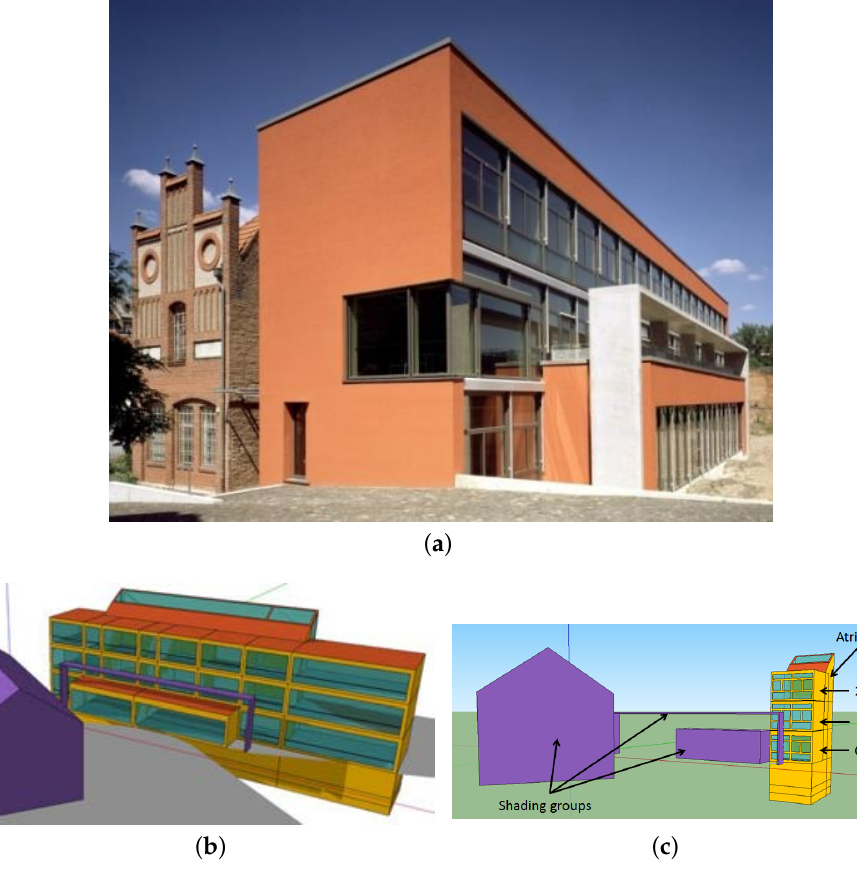
Figure 3. ZUB building and simplified tower model views: ( a ) External view of the ZUB building; ( b ) full-scale simulation model of the ZUB building; and ( c ) southeast view of the tower model with external shading